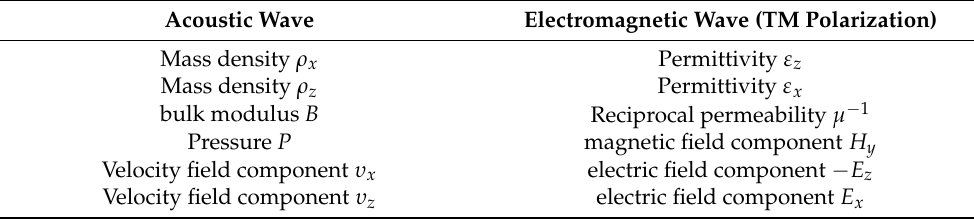
Table 1. The equivalence between the acoustic wave and the electromagnetic wave (TM